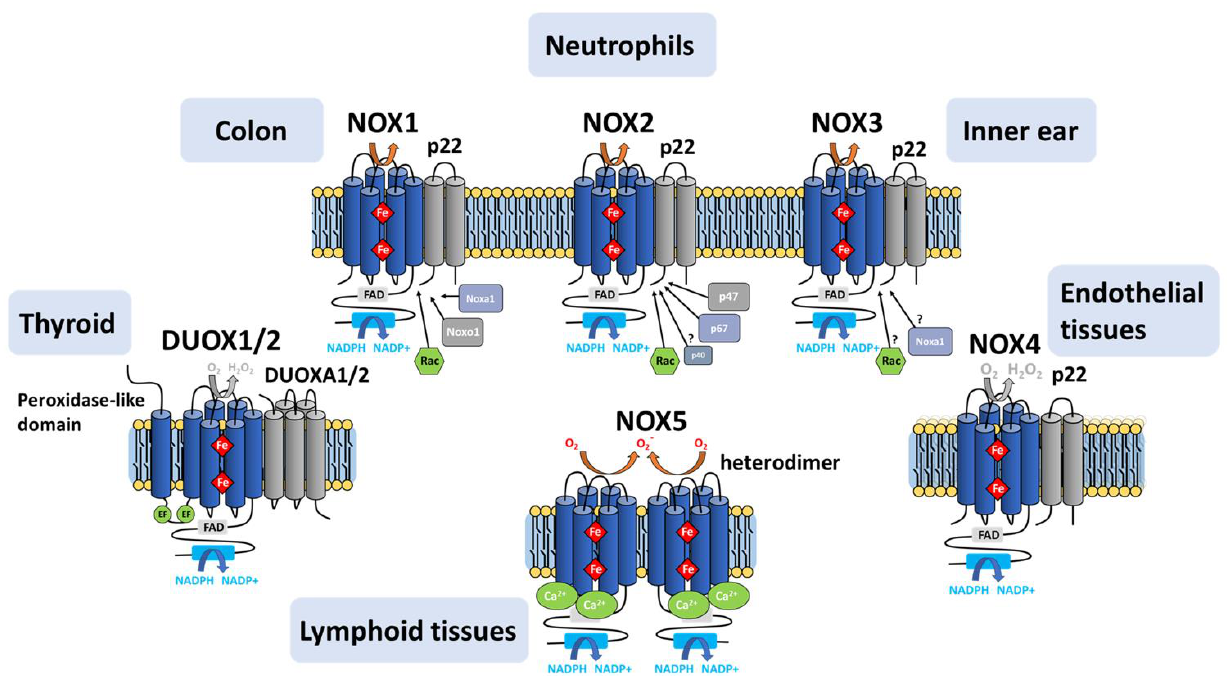
Figure 10. Representation of the NADPH oxidase isoforms. Despite their similar structure and enzymatic functions, the activation mechanisms of the NOX family enzymes differ. NOX1 activity requires p22 phox , NOXO1, NOXA1 and the small GTPase Rac; NOX2 requires p22 phox , p47 phox , p67 phox and Rac. NOX3 requires p22 phox and NOXO1 and may require NOXA1 depending on the species; Rac can participate but its necessity for activity is not clearly established. NOX4 requires p22 phox in vivo and is constitutively active. NOX5, DUOX1 and DUOX2 are activated by Ca 2+ ions; DUOX1 and DUOX2 require an association with the maturation factors DUOXA1/DUOXA2 for activation. NOX 1, 2, 3 and 5 produce mainly superoxide, Nox4 produces mainly H 2 O 2 , and DUOX1 and DUOX2 produce both [89].